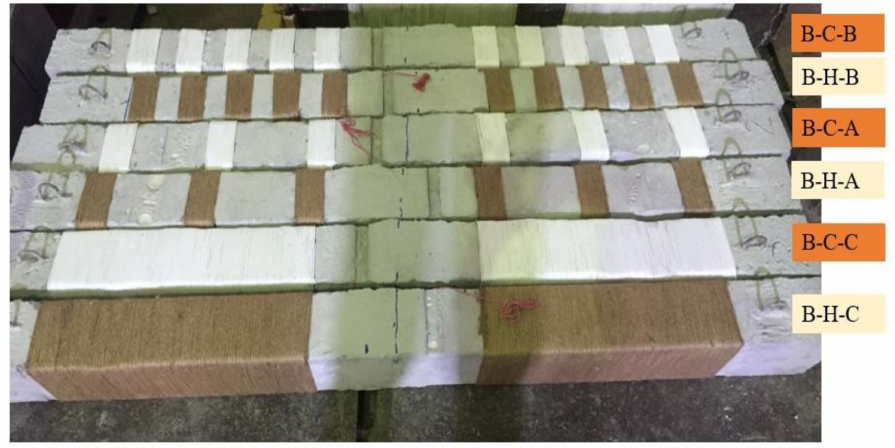
Figure 9. RC beams with different strengthening